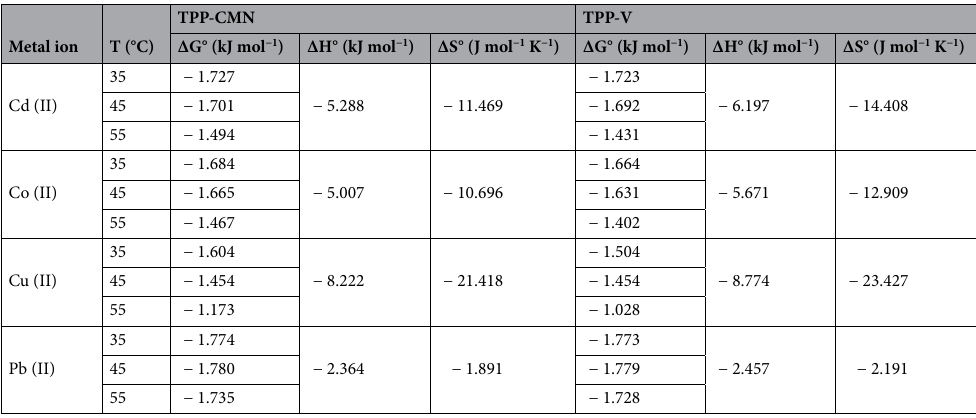
Table 3. Thermodynamic parameters for the adsorption of Cd (II), Co (II), Cu (II), and Pb (II) ions.